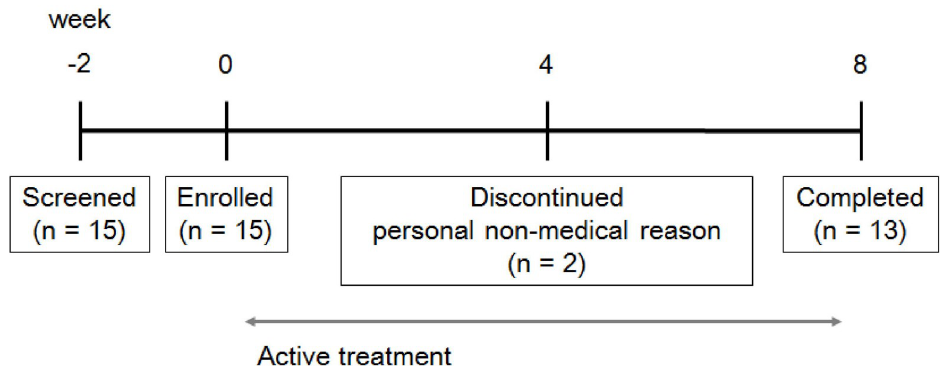
Fig 1. Flow chart of the